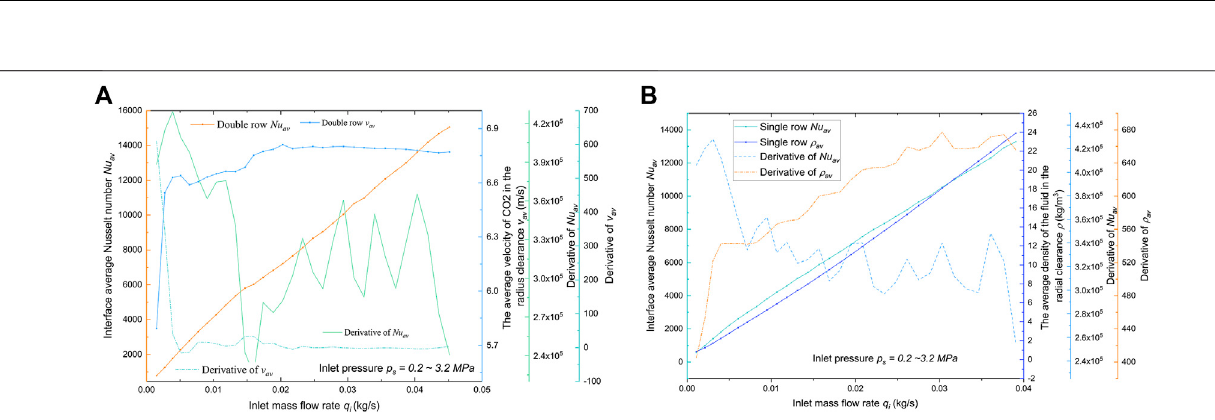
Frontiers in Energy Research |